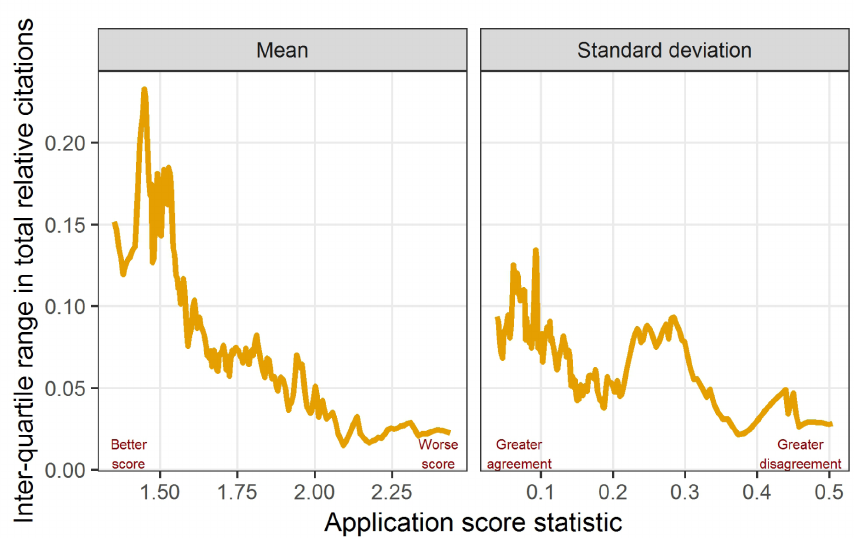
Figure 4. Scatter-plots of the standard deviation in total relative citations against application score statistics. Table 1. Parameter estimates for the multiple regression models predicting citation numbers. FP = fractional polynomial.